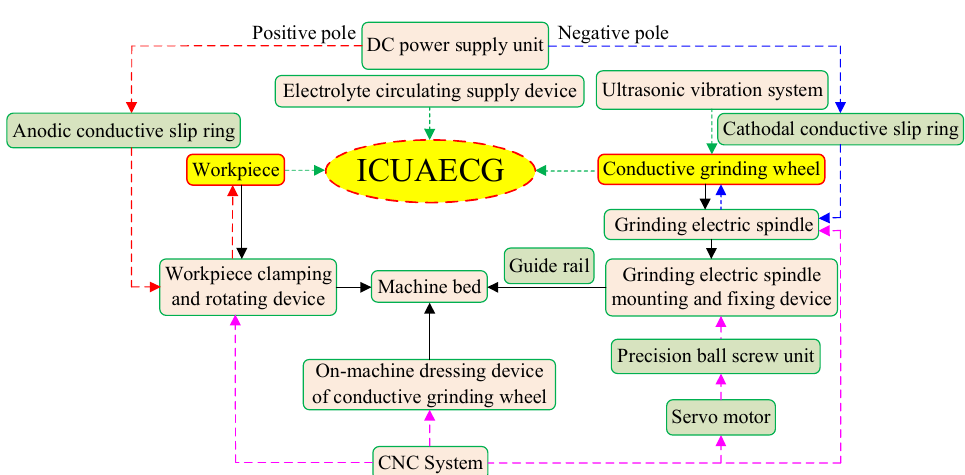
Figure 2. Main components of the ICUAECG machine tool.